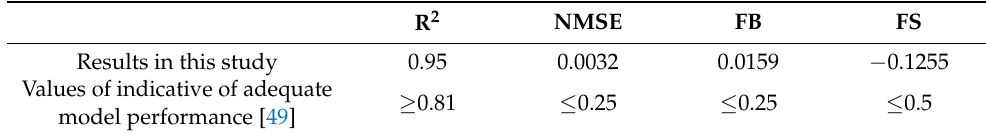
Table 2. Model performance evaluation